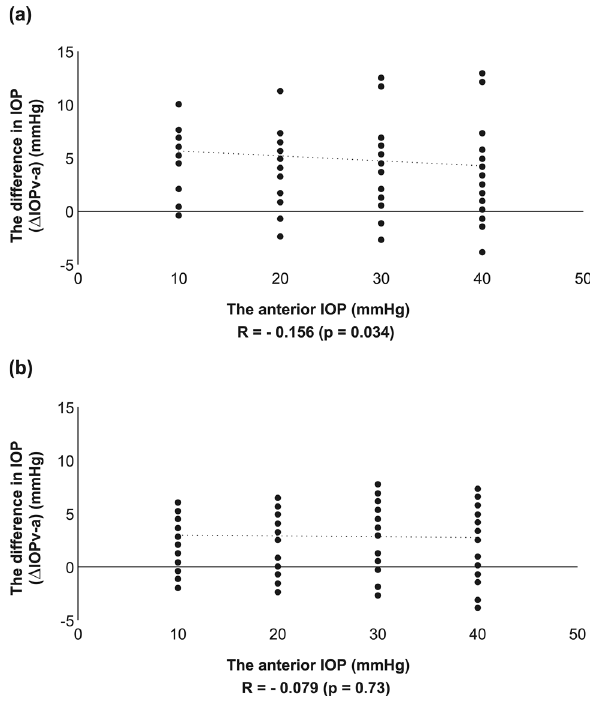
Figure 3. Scatterplots of the difference in IOPs between the anterior chamber and vitreous cavity (ΔIOPv-a, ordinate) under different anterior chamber IOP (abscissa) in the phakia group (n = 12) ( a ) and aphakia group (n = 12) ( b ). The ΔIOPv-a was not correlated with the anterior IOP in either